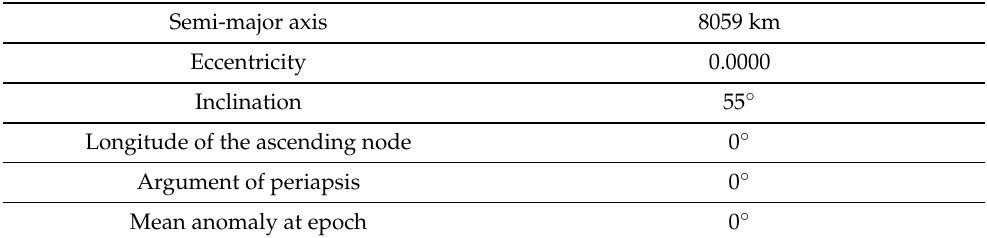
Table 4. Orbital elements of the seed satellite in Walker Delta 500/20/1